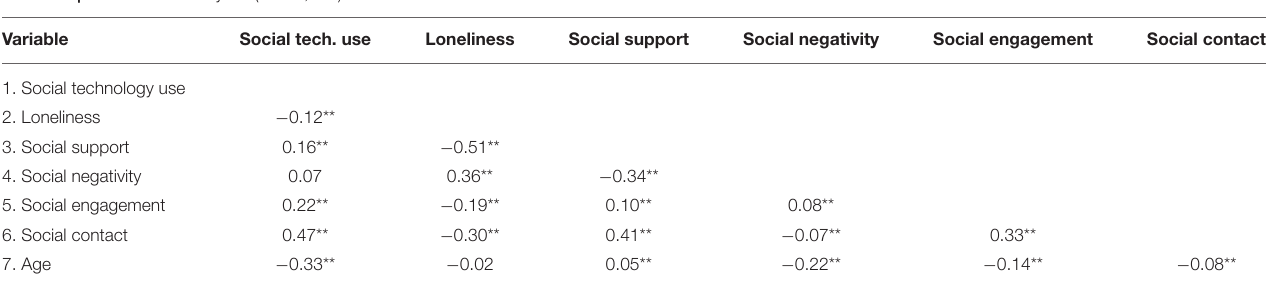
TABLE 3 | Correlational analyses ( N = 5,178).